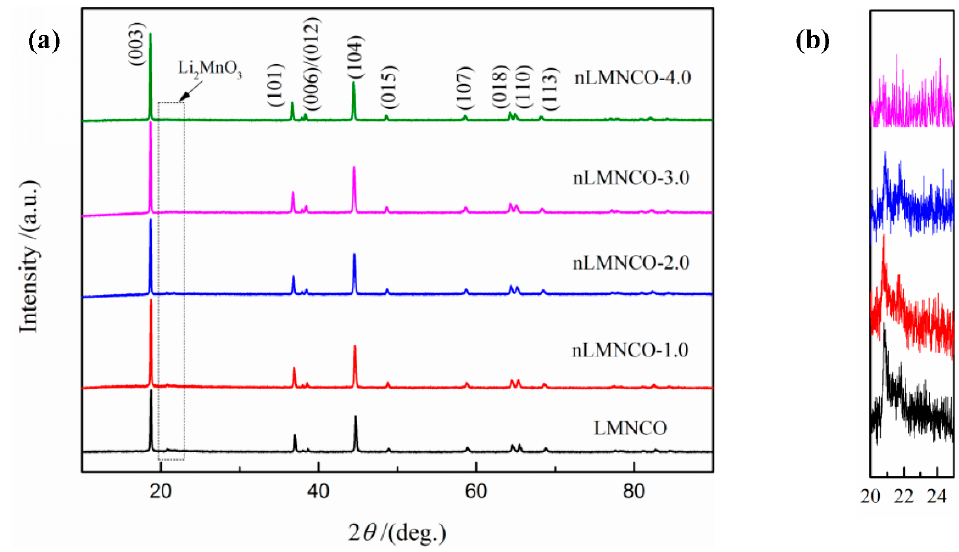
Figure 1. ( a ) Full XRD patterns of cathode materials and ( b ) local magnified XRD patterns at 20–25°.